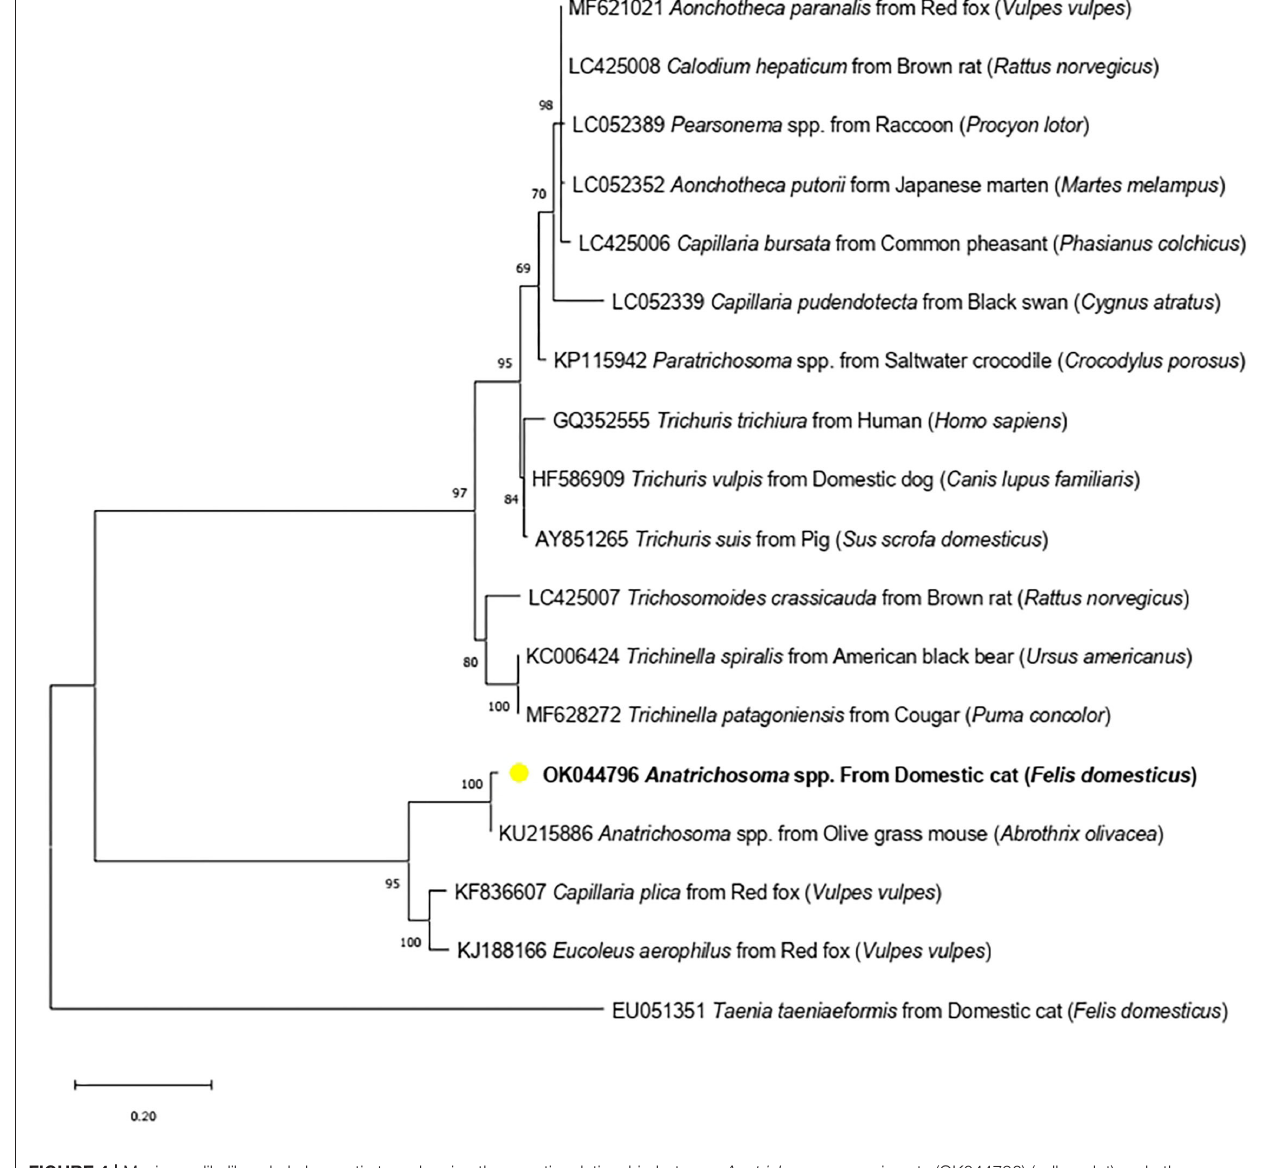
tract, in accordance with previous reports, particularly adult and egg morphologies of the nematode (12). Nematode eggs were also found, with characteristics of Capillaria -like eggs operculated on both ends. Anatrichosoma spp. should be listed as one of the causative agents of pododermatitis in cats (12, 13). Pathological changes during infection included eosinophil infiltration, as previously described (12, 13). Adult Anatrichosoma spp. were typically found in the superficial layer of various mucosal epithelial tissues, including nasal, stomach, eye, skin and buccal cavities (5, 13, 16, 17). Female adults were commonly found in the superficial layer and males in the submucosal layer (13,